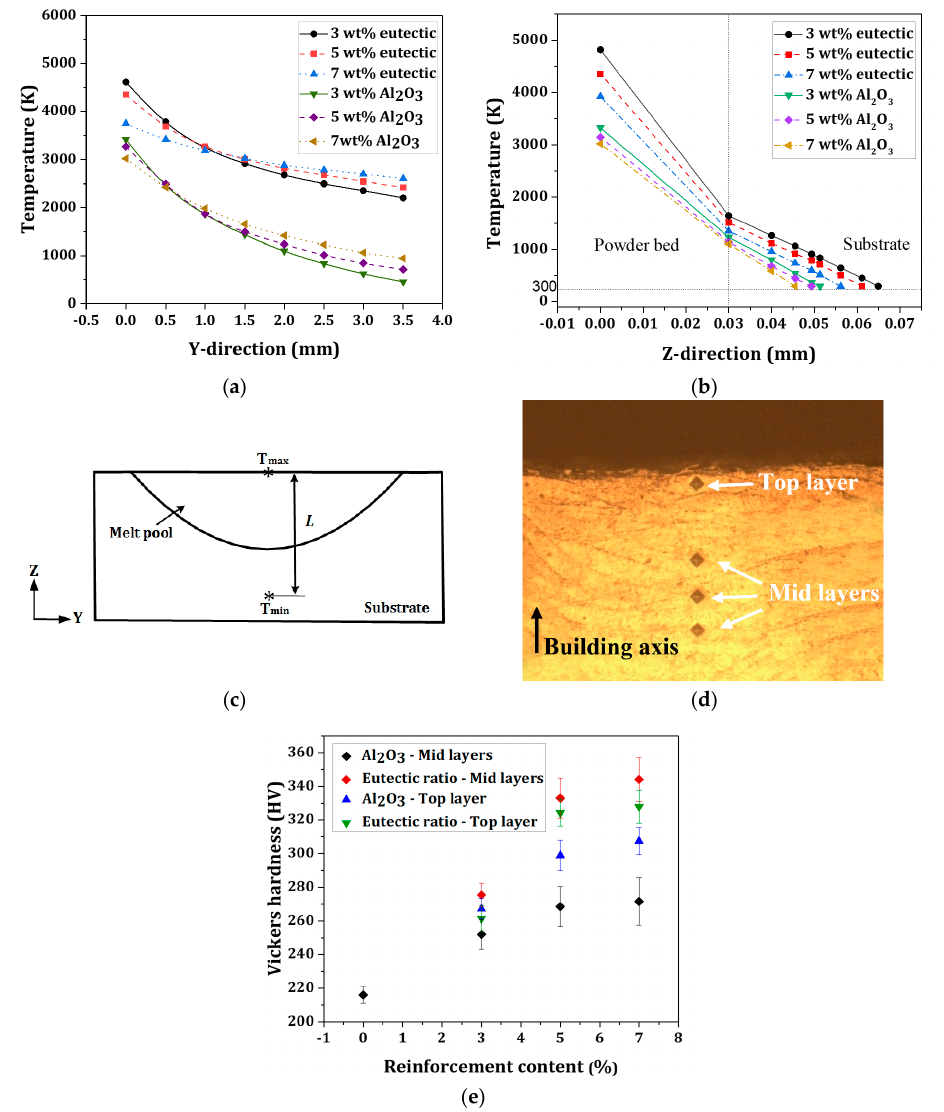
Figure 8. Temperature distribution. ( a ) Along the Y - direction at the top surface. ( b ) Along the Z - direction, i.e., thickness direction. ( c ) Definition of the distance between the points of the maximum and minimum temperatures ( L ). ( d ) The locations for measuring the micro-hardness. ( e ) Measurements of micro-hardness at different conditions and locations.